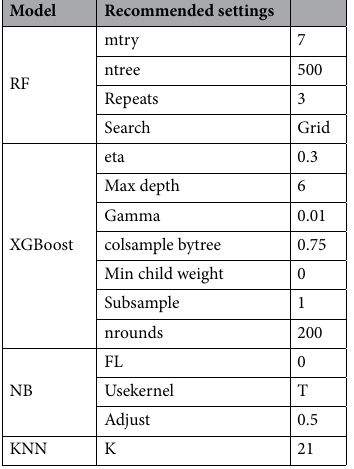
Table 1. Recommended settings for the